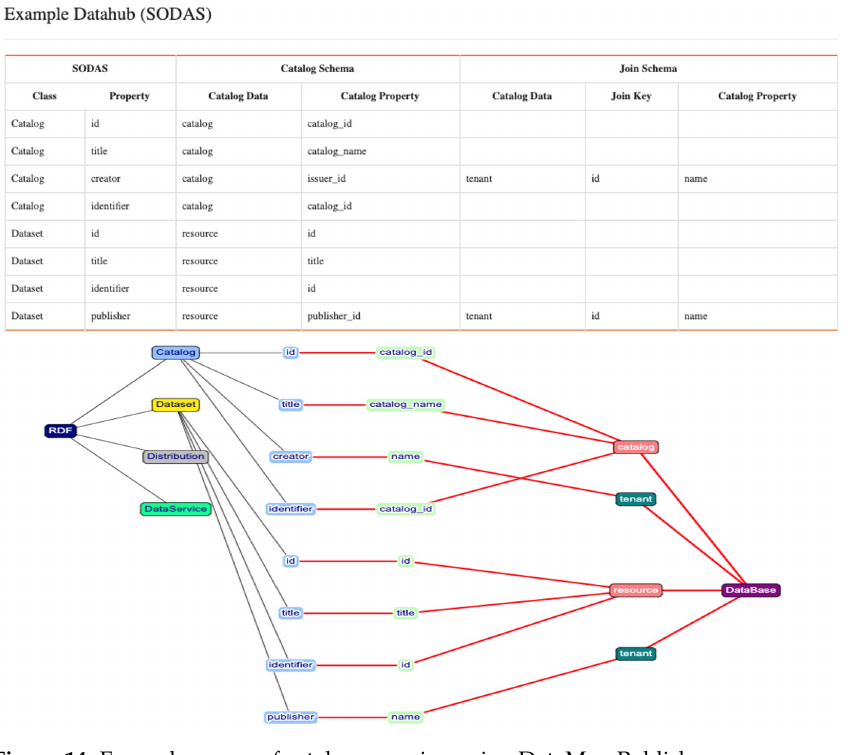
Figure 14. Example screen of catalog mapping using DataMap Publisher.